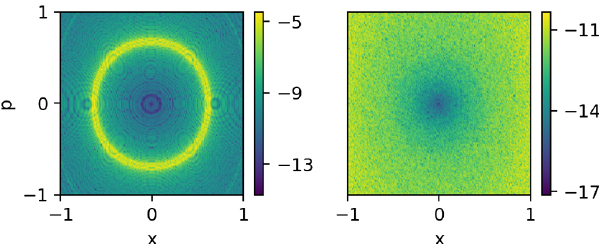
FIG. 28. Dynamic aperture plot with a thick octupole near the quarter-integer resonance using FMA(left) and REM(right) with the time interval T ¼ 256